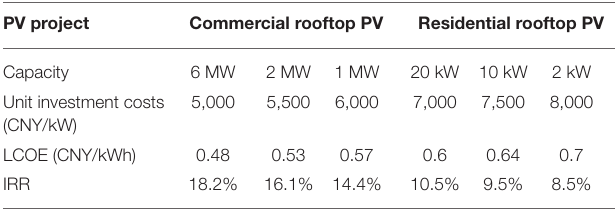
TABLE 8 | The impact of subsidy retreat on the LCOE and IRR of rooftop PV in Beijing. PV